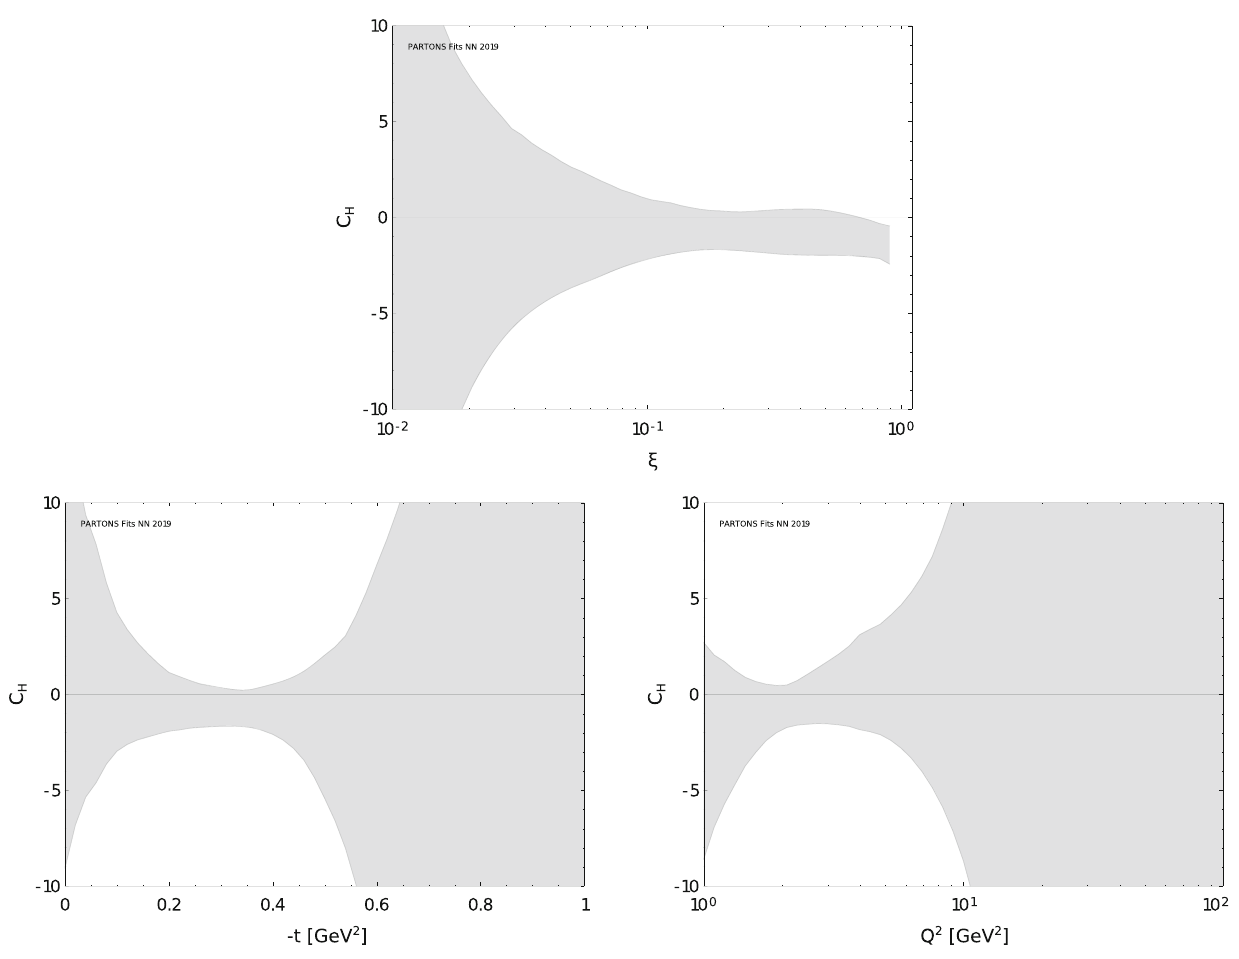
Fig. 23 Subtraction constant evaluated from the CFF H as a function of ξ for t = − 0 . 3 GeV 2 and Q 2 = 2 GeV 2 (top), as a function of − t for ξ = 0 . 2 and Q 2 = 2 GeV 2 (bottom left) and as a function of Q 2 for ξ = 0 . 2 and t = − 0 . 3 GeV 2 (bottom